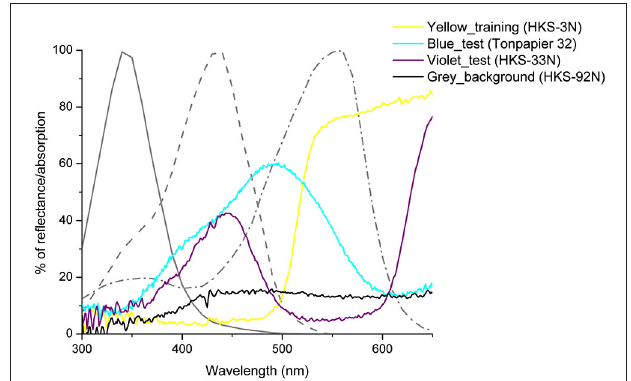
FIGURE 1 | Spectral reflection curves of the stimuli used in our experiments and relative absorptions of the three honeybee’s photoreceptors, S, M and L (shown in gray) . The colors distances between these colors in two perceptual spaces proposed for the honey bee, the color hexagon (Chittka, 1992) and the color opponent coding space (Backhaus, 1991) were high enough as to allow discrimination in all cases (Dyer et al., 2008; see Table 1 ).